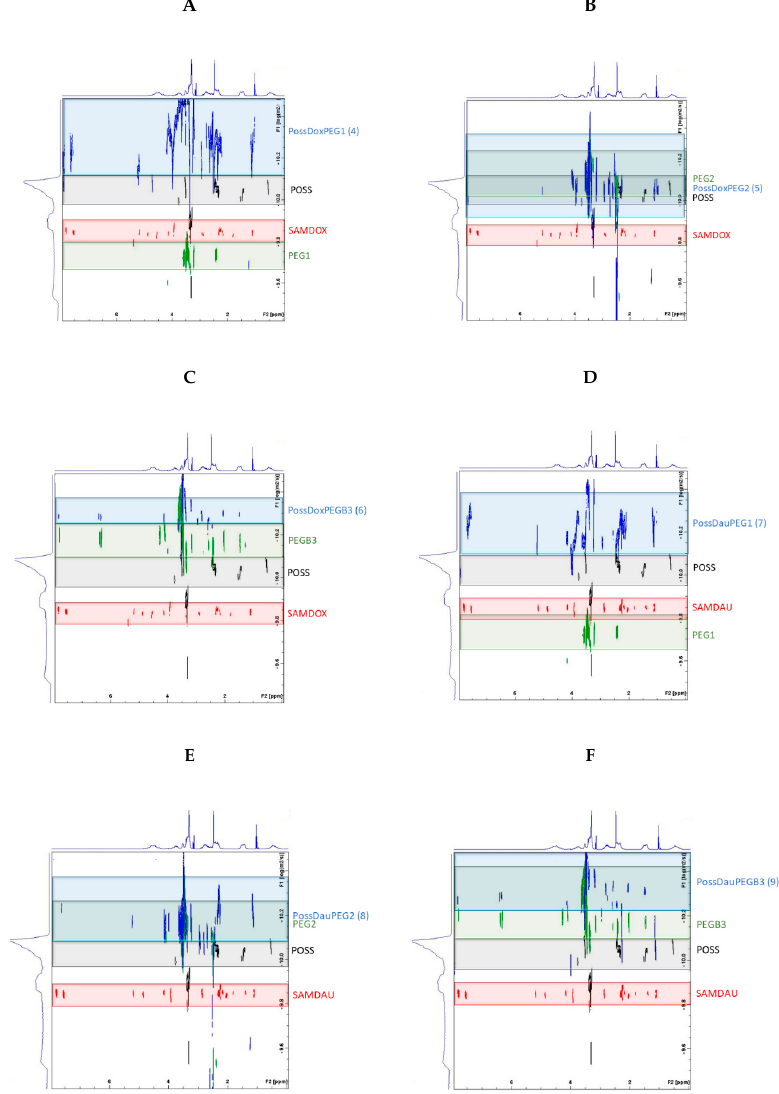
Figure 7. Superimposition of the DOSY spectra of the substrates (SAMDOX/SAMDAU, PEG1/PEG2/PEGB3 and POSS(OH) 32 ) on the DOSY spectra of the products (conjugates 4 – 9 ). ( A ) PossDoxPEG1 ( 4 ); ( B ) PossDoxPEG2 ( 5 ); ( C ) Poss- DoxPEGB3 ( 6 ); ( D ) PossDauPEG1 ( 7 ); ( E ) PossDauPEG2 ( 8 ); ( F ) PossDauPEGB3 ( 9